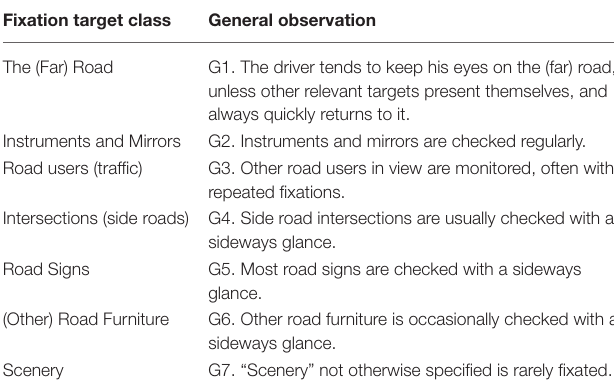
TABLE 2 | Overall fixation target classification and general observations (G1–G7) about the